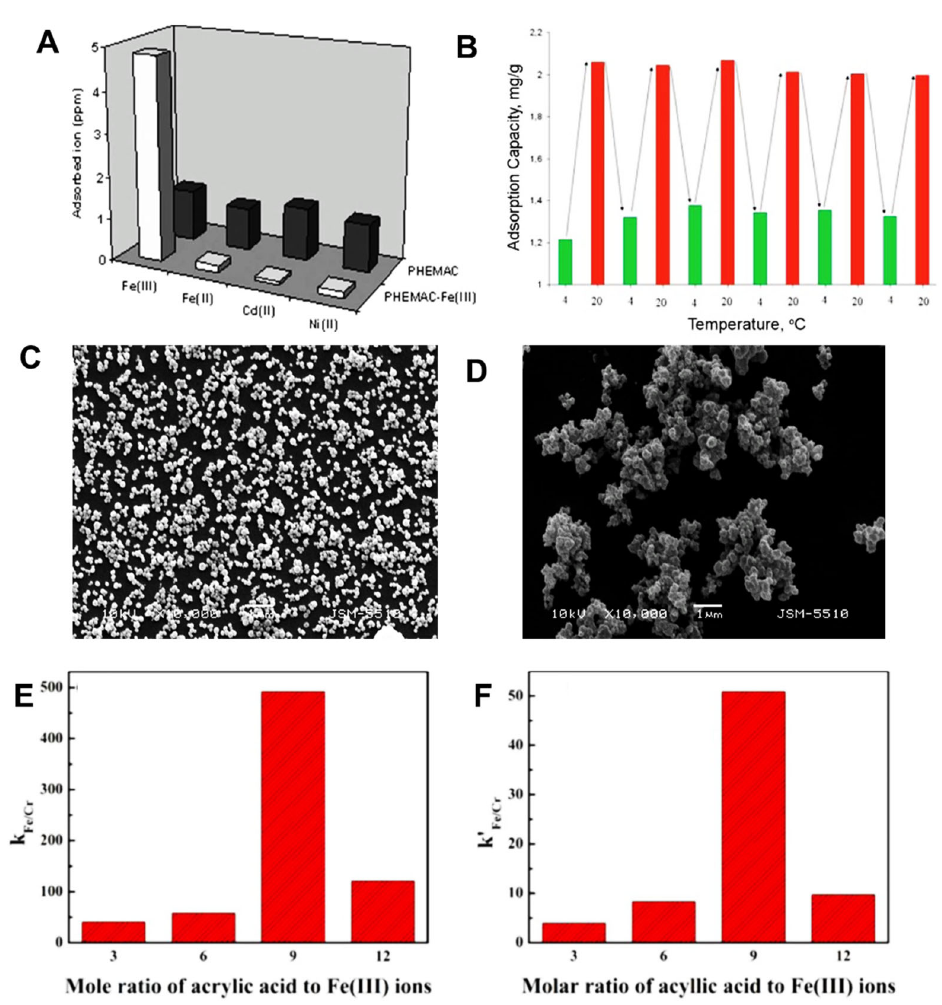
Figure 11. ( A ) Adsorbed template and competitive ions onto PHEMAC and PHEMAC-Fe(III) monoliths for Fe(III)/competitive ion pairs (reproduced with permission from Ref. [114]. Copyright 2010 John Wiley and Sons). ( B ) Adsorption of Fe(III) at two temperatures (reproduced with permission from [115]). SEM images of NIP ( C ) and Fe(II)-IIP ( D ) particles; Mag 10000x (reproduced with permission from Ref. [119]. Copyright 2017 Elsevier). Effect of the mole ratio between AA and Fe(III) on the selectivity factor ( E ) and relative Selectivity factor ( F ) (reproduced with permission from Ref. [120]. Copyright 2019 Elsevier).